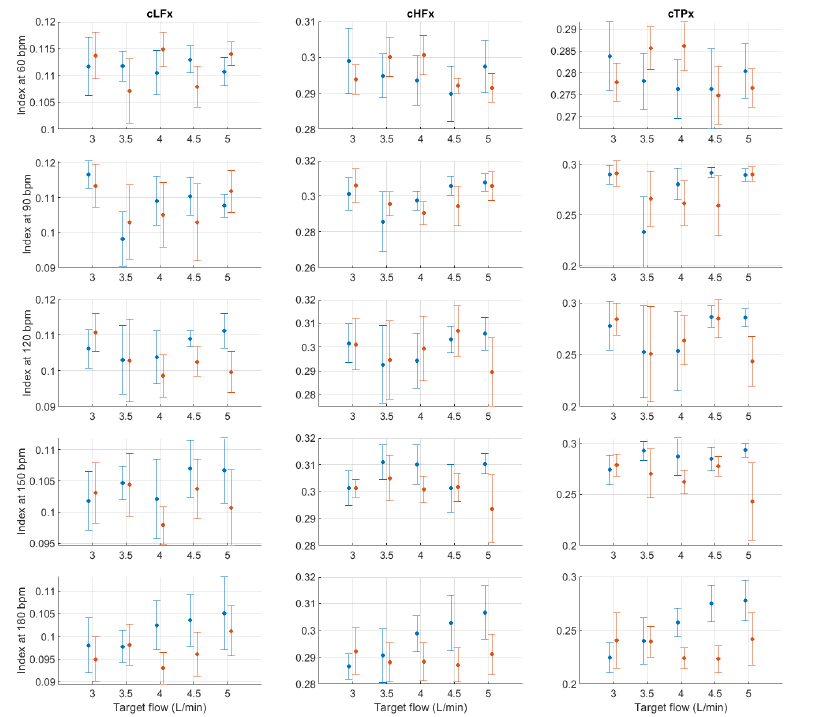
Figure A11. Mean and standard deviation of the x -coordinates of the centroid-related indices extracted from pulse rate variability under different stroke rates (SR) and target flows (TF, TF above 2.5 L/min) conditions, and measured from the radial (blue) and deep palmar arch (orange) phantoms.